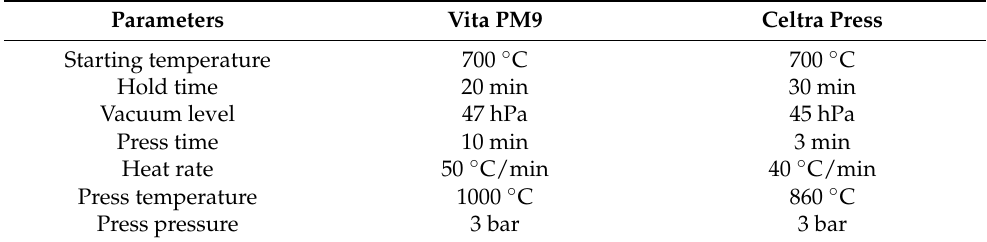
Table 3. Parameters for hot-pressing ceramic according to the manufacturer